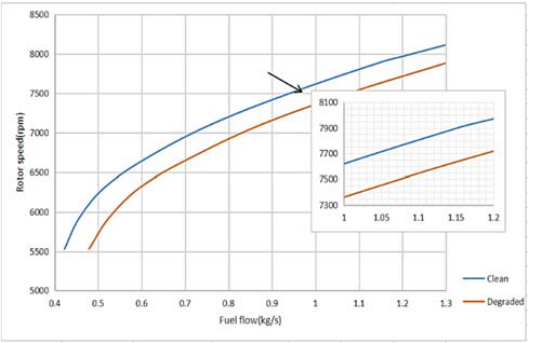
Figure 20. Comparison of the fuel flow to rotor speed relationship between a clean engine and degraded engine .